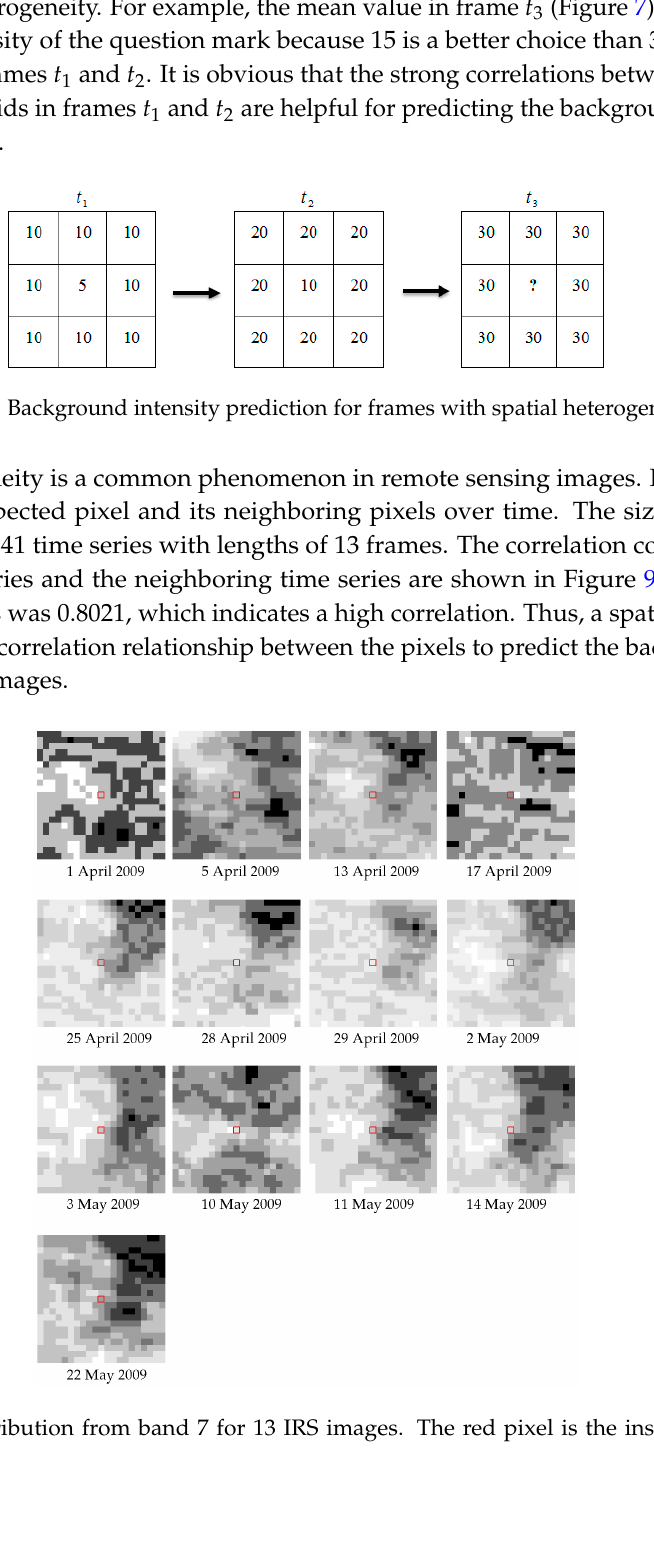
Figure 8. BTs distribution from band 7 for 13 IRS images. The red pixel is the inspected pixel in the window.